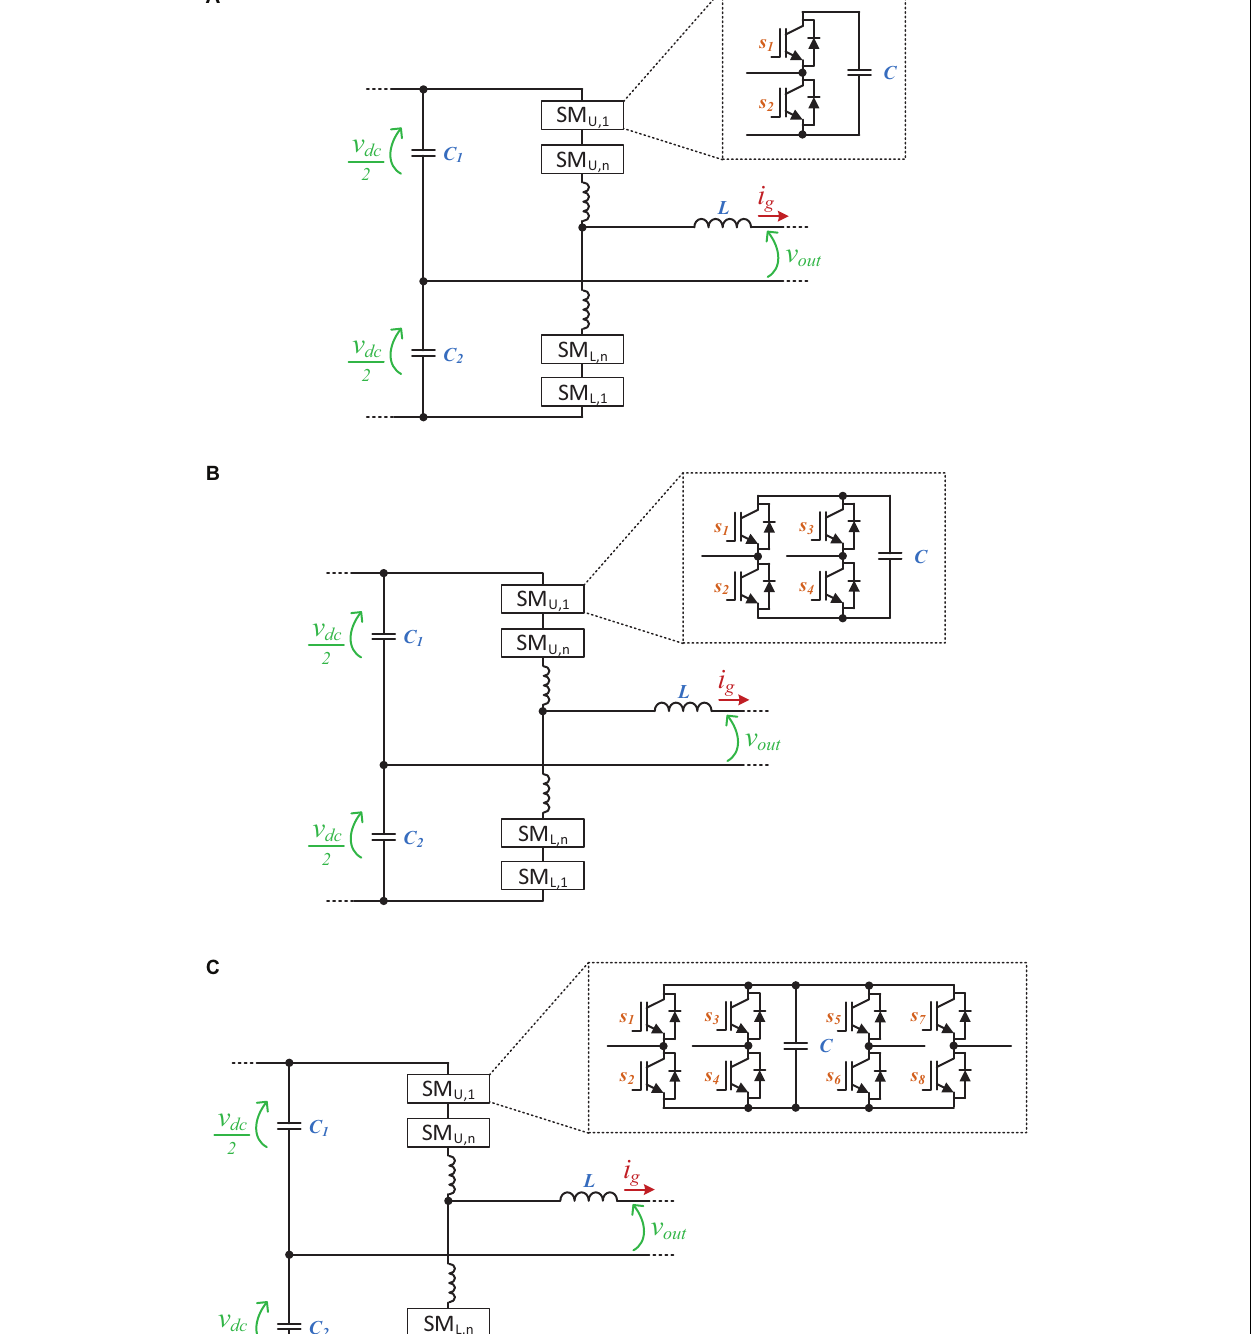
since each switch state can be assigned in a way that avoids redundant switching. A similar strategy, called pulse decoding, can be seen in Ge and Fang (2008), where only one